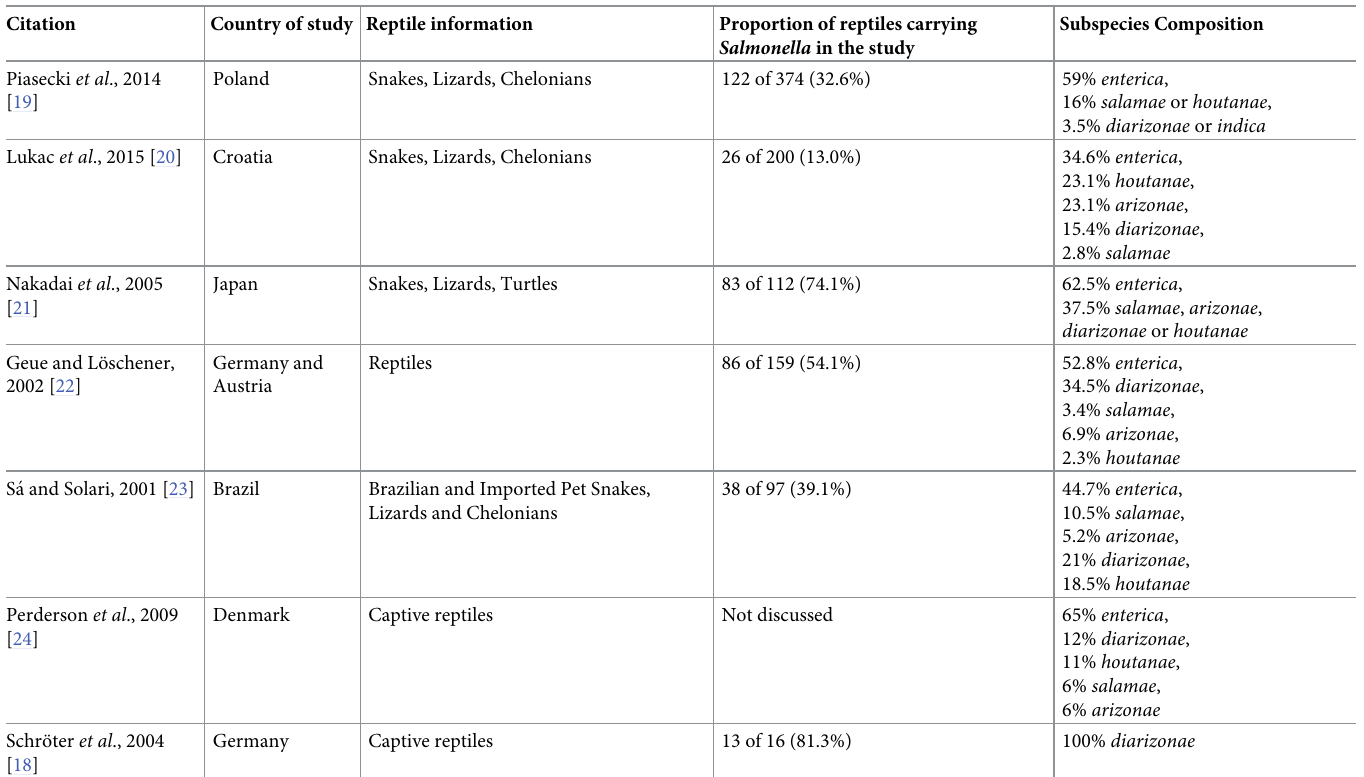
Table 1. The distribution of Salmonella subspecies in non-venomous